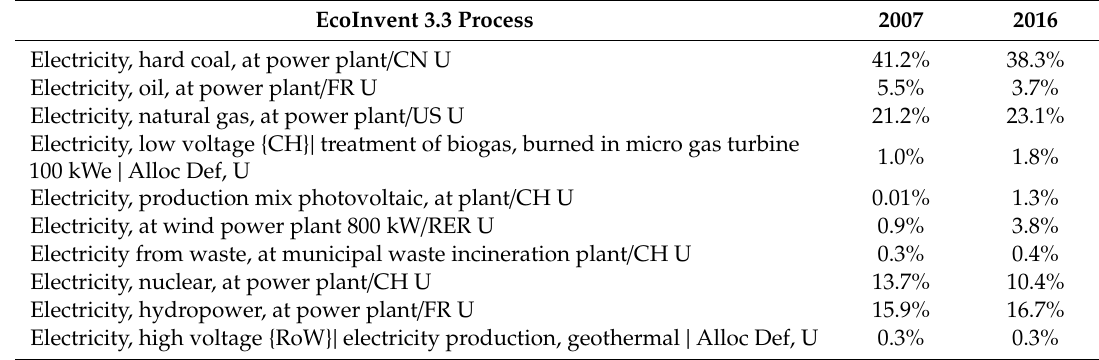
Table A1. World electricity modeling with EcoInvent data [70] in accordance with International Energy Agency [1] information.